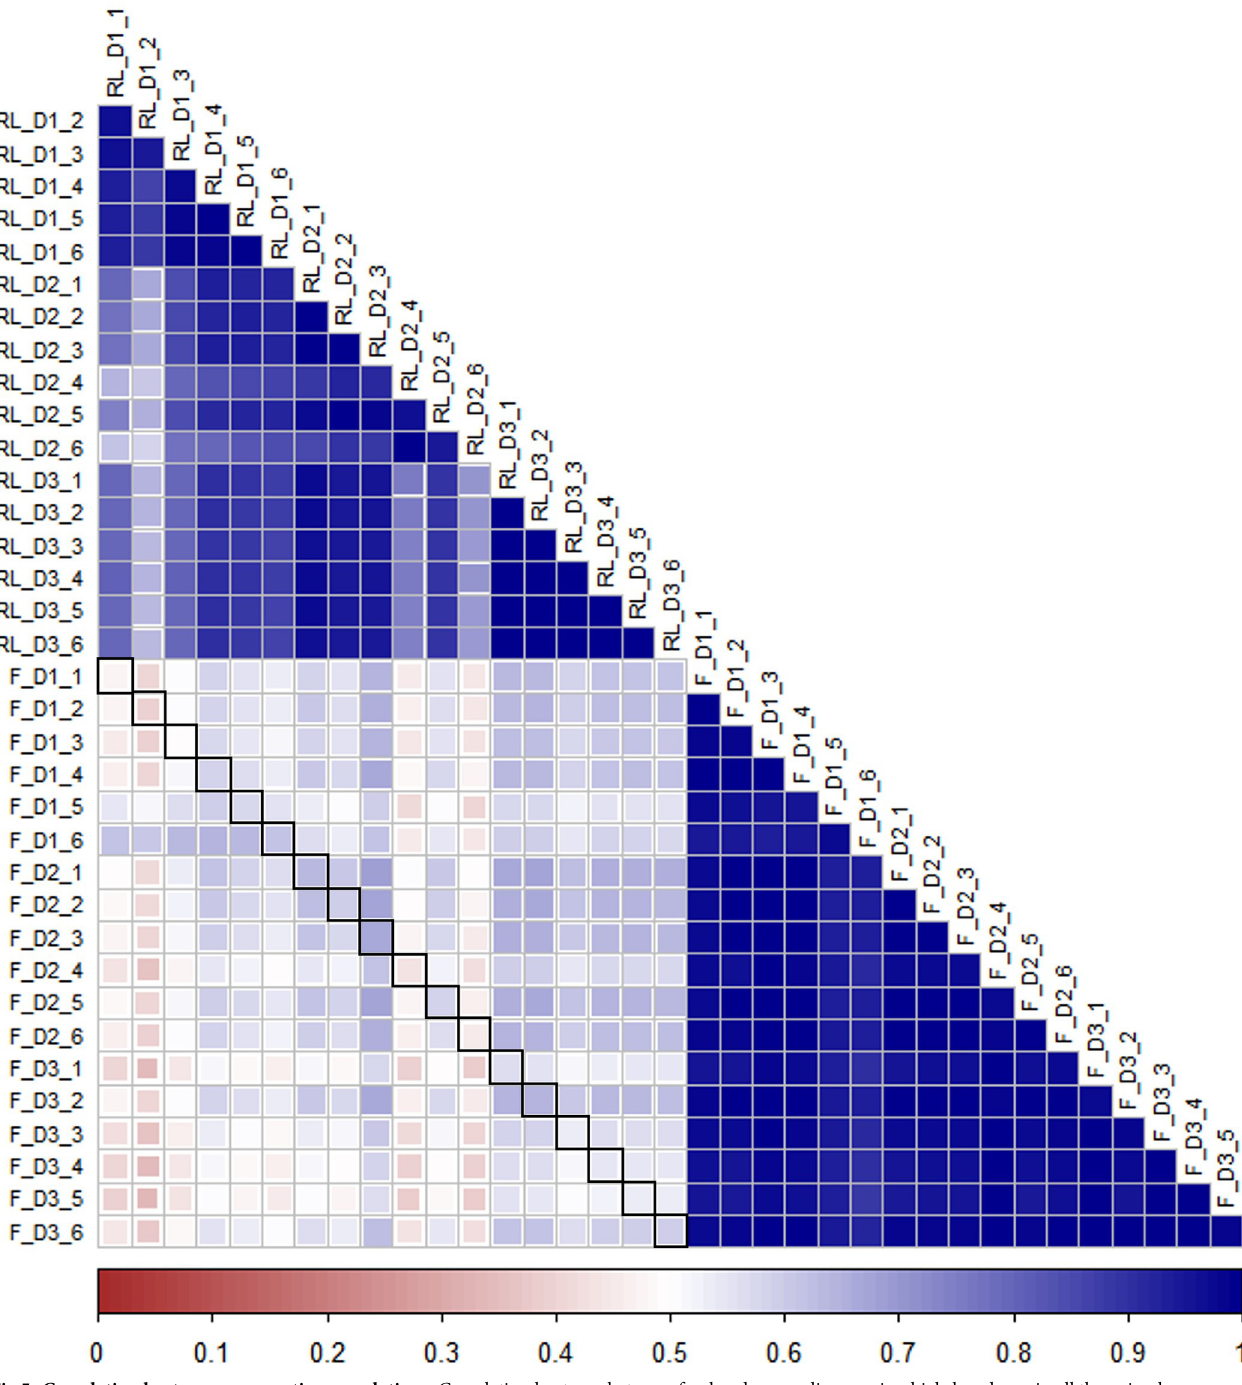
PLOS ONE | https://doi.org/10.1371/journal.pone.0274371 January 13, 2023 11 /